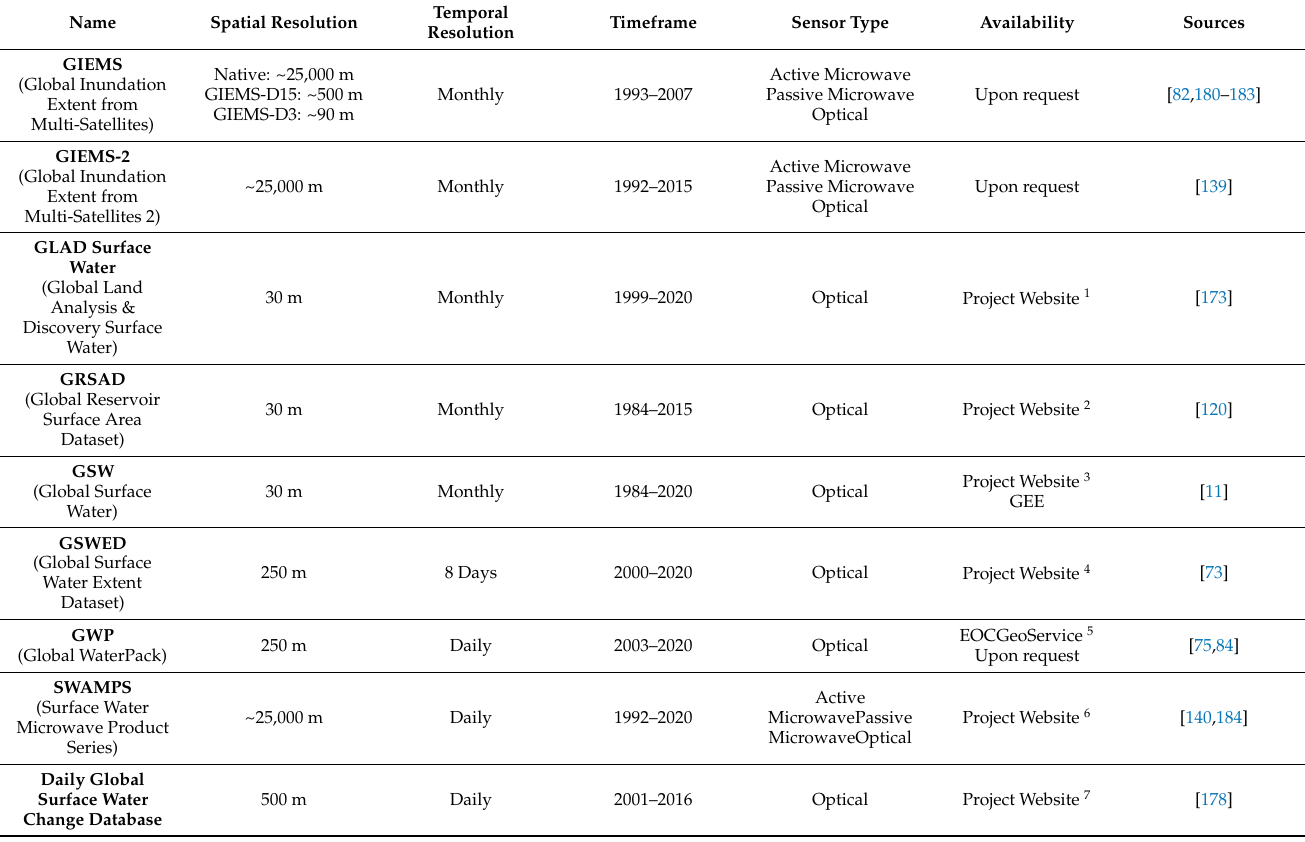
Table 1. Overview of available dynamic global inland surface water